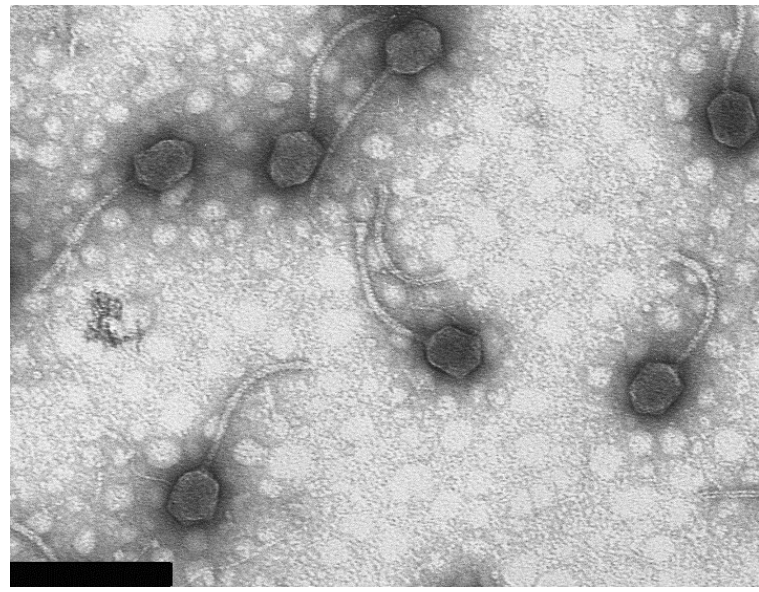
Figure 1. Bacteriophage 9g particle morphology. The bacteriophage T4 particles were used for calibration of the instrument magnification (the length of T4 tail is 113 nm [24]). Bar represents 200